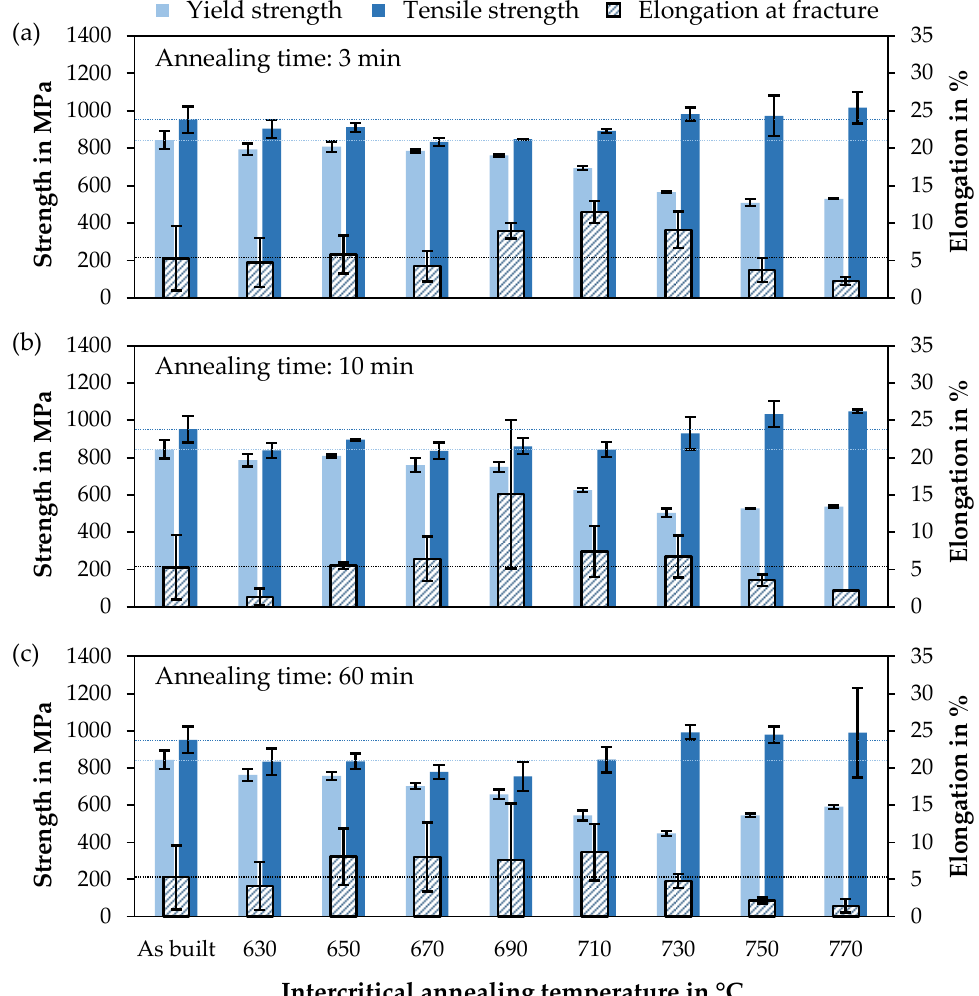
Figure 2. Mechanical properties as a function of annealing temperature for 3 annealing times (( a ) 3 min, ( b ) 10 min and ( c ) 60 min) with the results as-built as horizontal lines.